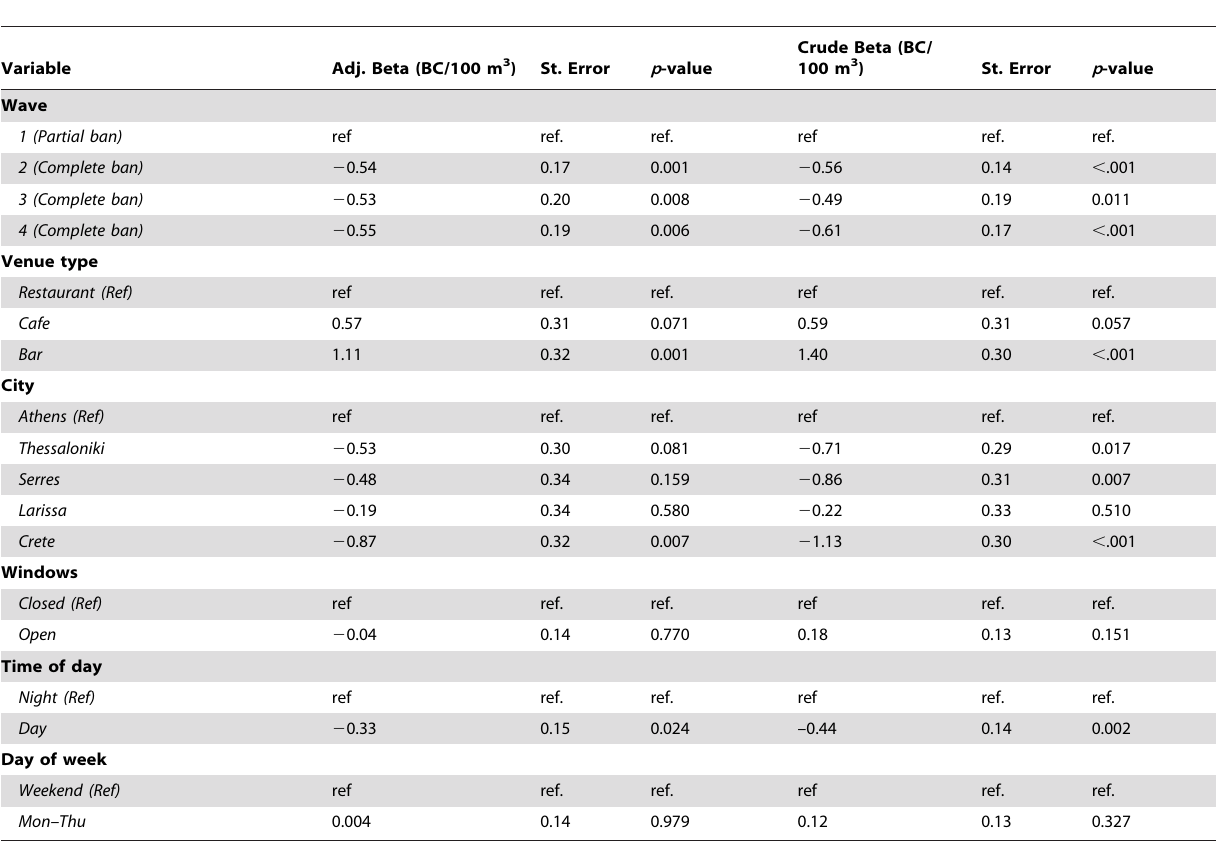
Table 5. Adjusted 1 and crude linear regression models for the relationship between venue and measurement characteristics and smoker density 2 levels, within hospitality venues in Greece (N =445), 2010–2011.